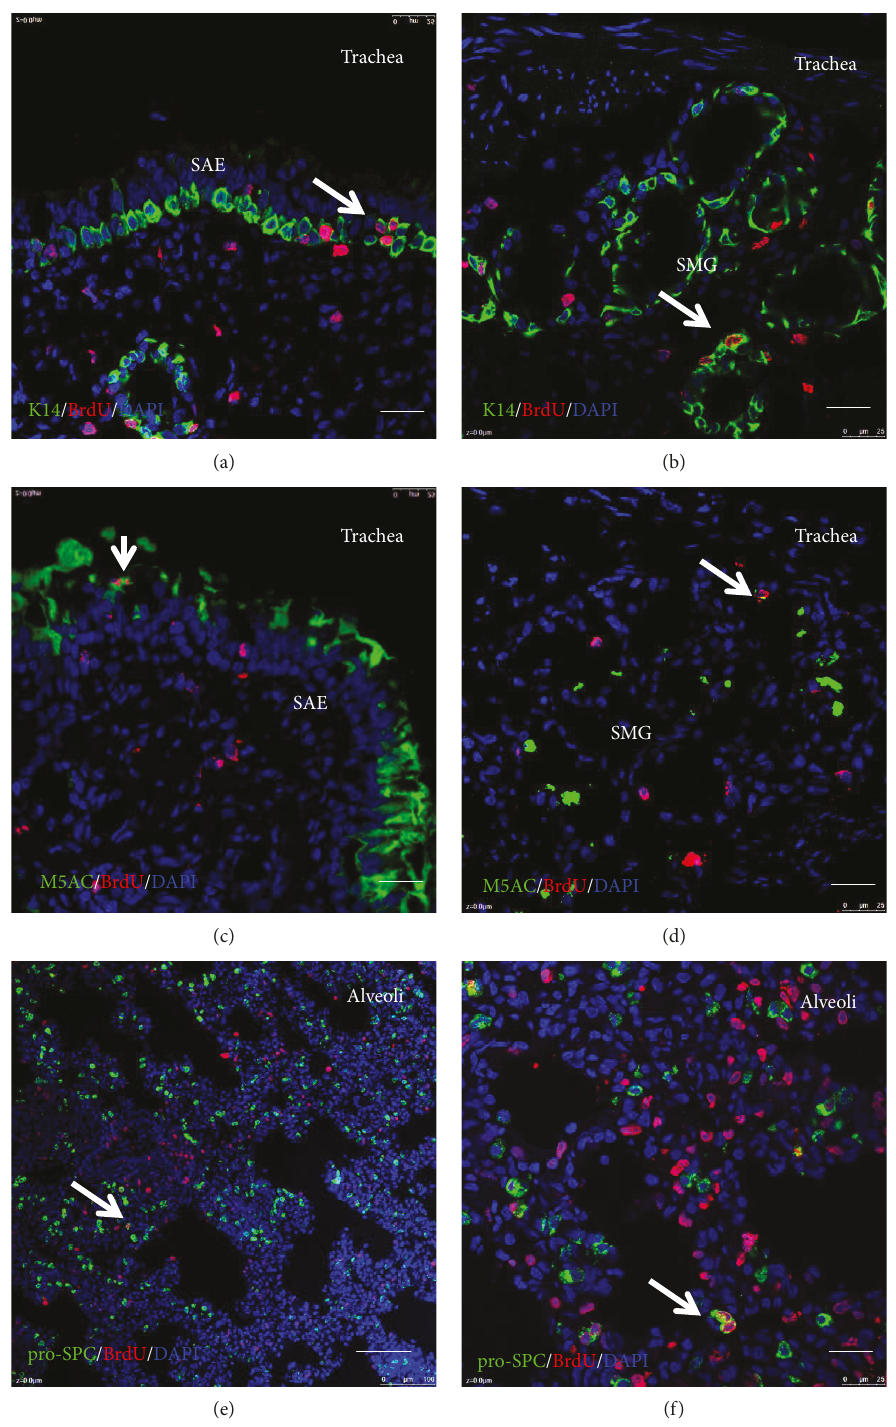
Figure 5: E ffi ciency of BrdU labeling in epithelial cells of a newborn porcine lung. The BrdU labeling e ffi ciency was determined by immuno fl uorescence staining of BrdU and epithelial cell markers. Representative images of IF staining for colocalization of BrdU and epithelial cell type markers keratin 14, mucin 5AC, and ProSPC in the trachea and distal lung of porcine at day 1 post BruU pulse. (a, b) Colocalization of keratin 14 (green) and BrdU (red) in the surface airway epithelium (SAE) (a) and submucosal glands (SMG) (b) in the middle trachea of a porcine lung. (c, d) Colocalization of mucin 5AC (green) and BrdU (red) in the surface airway epithelium (SAE) (c) and submucosal glands (SMG) (d) in the middle trachea of a porcine lung. (e, f) Low (e) and high (f) magni fi cations of images of colocalization of ProSPC (green) and BrdU (red) in the alveolar region of a porcine distal lung. Nuclear stained with DAPI (blue). Bar=50 μ m in (a, c, e). Bar=100 μ m in (b, d,